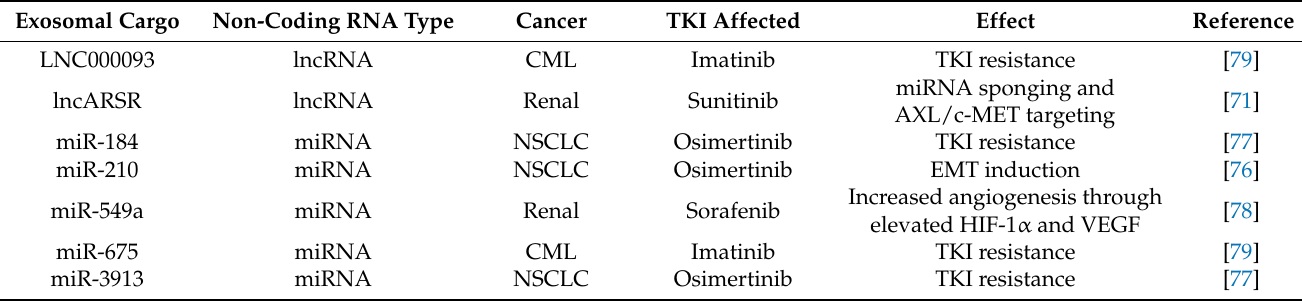
Table 4. Exosome-mediated TKI